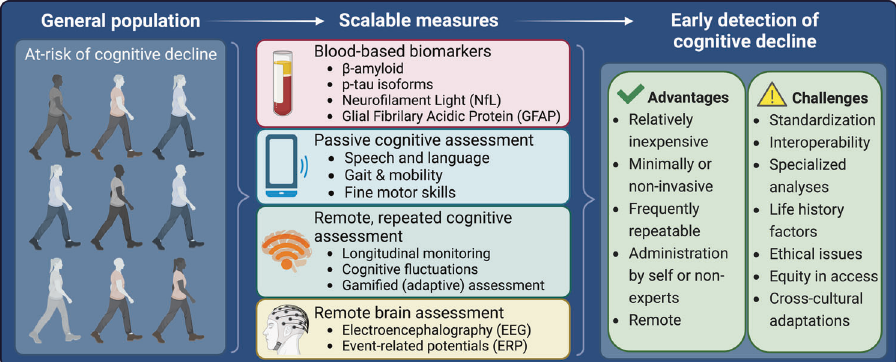
Fig. 1 An overview of scalable measures for early detection of cognitive decline. Left panel: within the general population, those deemed “ at-risk ” would bene fi t most from early screening. Middle panel: List of scalable measures and some examples in each category. Right panel: Advantages and Challenges associated with scalable